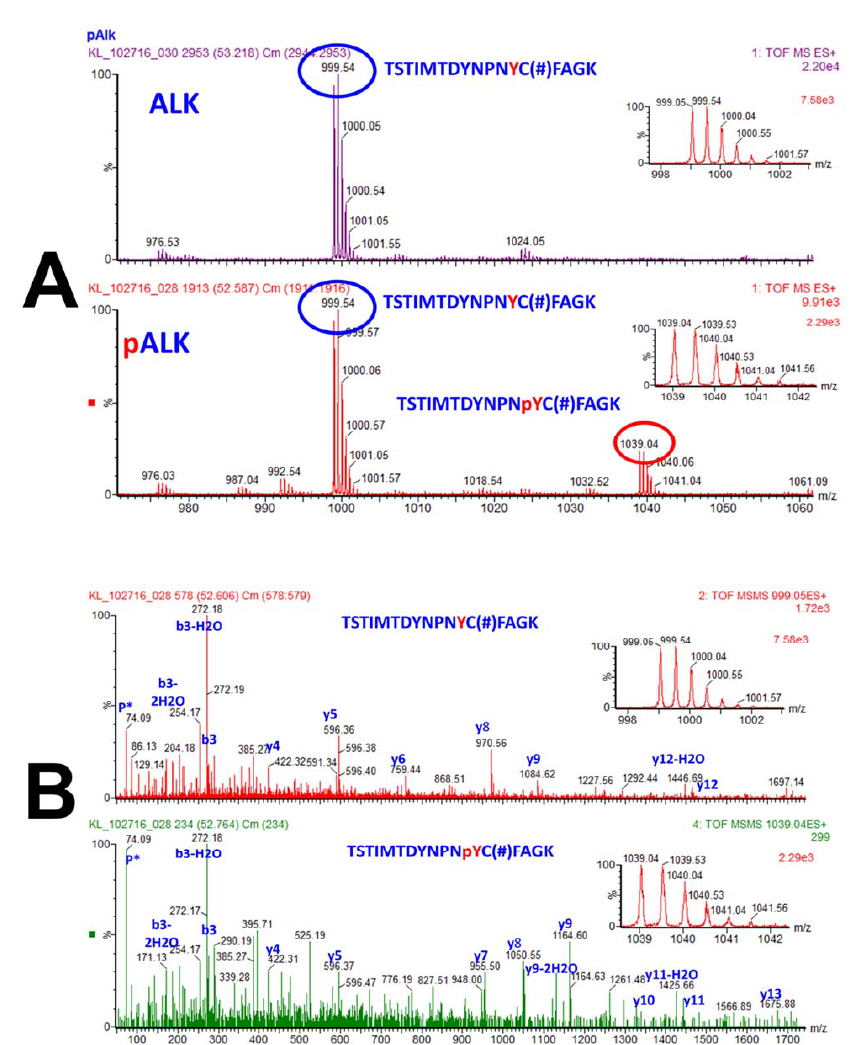
Figure 4. Identification and quantification of a phosphopeptide, and localization of a phosphorylation on a tyrosine residue within a peptide. ( A ): The MS spectra of the precursor ions with m/z of 999.05 (2+) and 1039.04 (2+) that correspond to unphosphorylated peptide TSTIMTDYNPNYC(#)FAGK and its phosphorylated counterpart TSTIMTDYNPNpYC(#)FAGK. Note that C(#) represents cysteine modified by acrylamide (propionamide) and pY corresponds to phosphorylated tyrosine residue. While the top spectrum contains only the unphosphorylated peptide, the bottom spectrum contains precursor ions that correspond to both unphosphorylated and phosphorylated peptides (and the ratio of the two precursor ions indicates the percentage of phosphorylation of that peptide). Note that the peptide discussed is part of ALK, anaplastic lymphoma kinase (ALK) protein. ( B ): The MS/MS spectra of the precursor ions that correspond to the unphosphorylated and phosphorylated peptide not only confirm phosphorylation of this peptide, but also the location of this modification. Note that this peptide contains two tyrosine, two threonine and a serine residue, all of which can be potentially phosphorylated, yet the phosphorylation happens at only one specific tyrosine residue. Fragmentation of the precursor ions in MS/MS produced a series of b and y fragment ions that correspond to the unphosphorylated (top) and phosphorylated (bottom) peptide. Simply identifying y8 and y9 as not phosphorylated (top MS/MS spectrum), and y7, y8, and y9 are sufficient to demonstrate that the tyrosine residue adjacent and upstream of cysteine residue is the phosphorylated amino acid. Furthermore, y10 and y11 demonstrate that the next tyrosine upstream is not phosphorylated, and the m/z of the y13, b3, and the precursor ion indicate that none of the three serine and one threonine residues are phosphorylated. Reproduced from Reference